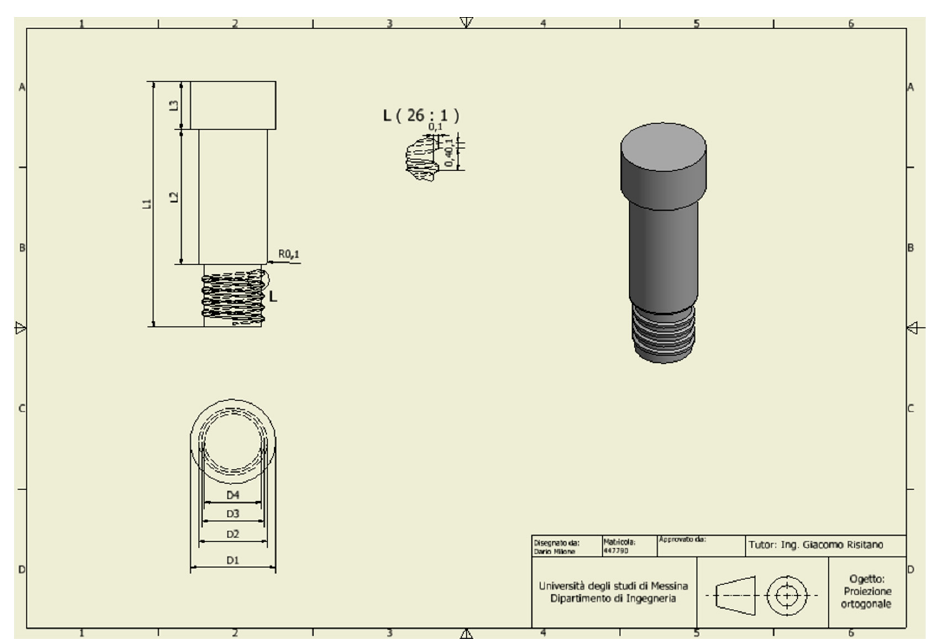
Figure 4. A particular drawing of the passant screw selected for the abutment–fixture–bar connection.